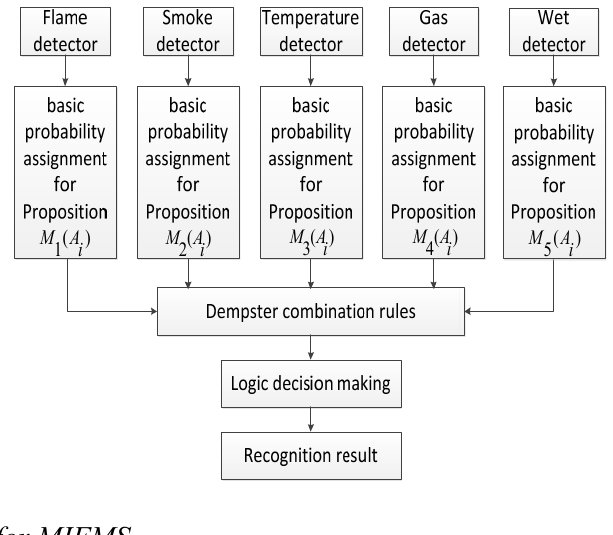
Figure 1. Basic system structure of a multi-sensor intelligent fire monitoring system (MIFMS) based on D-S